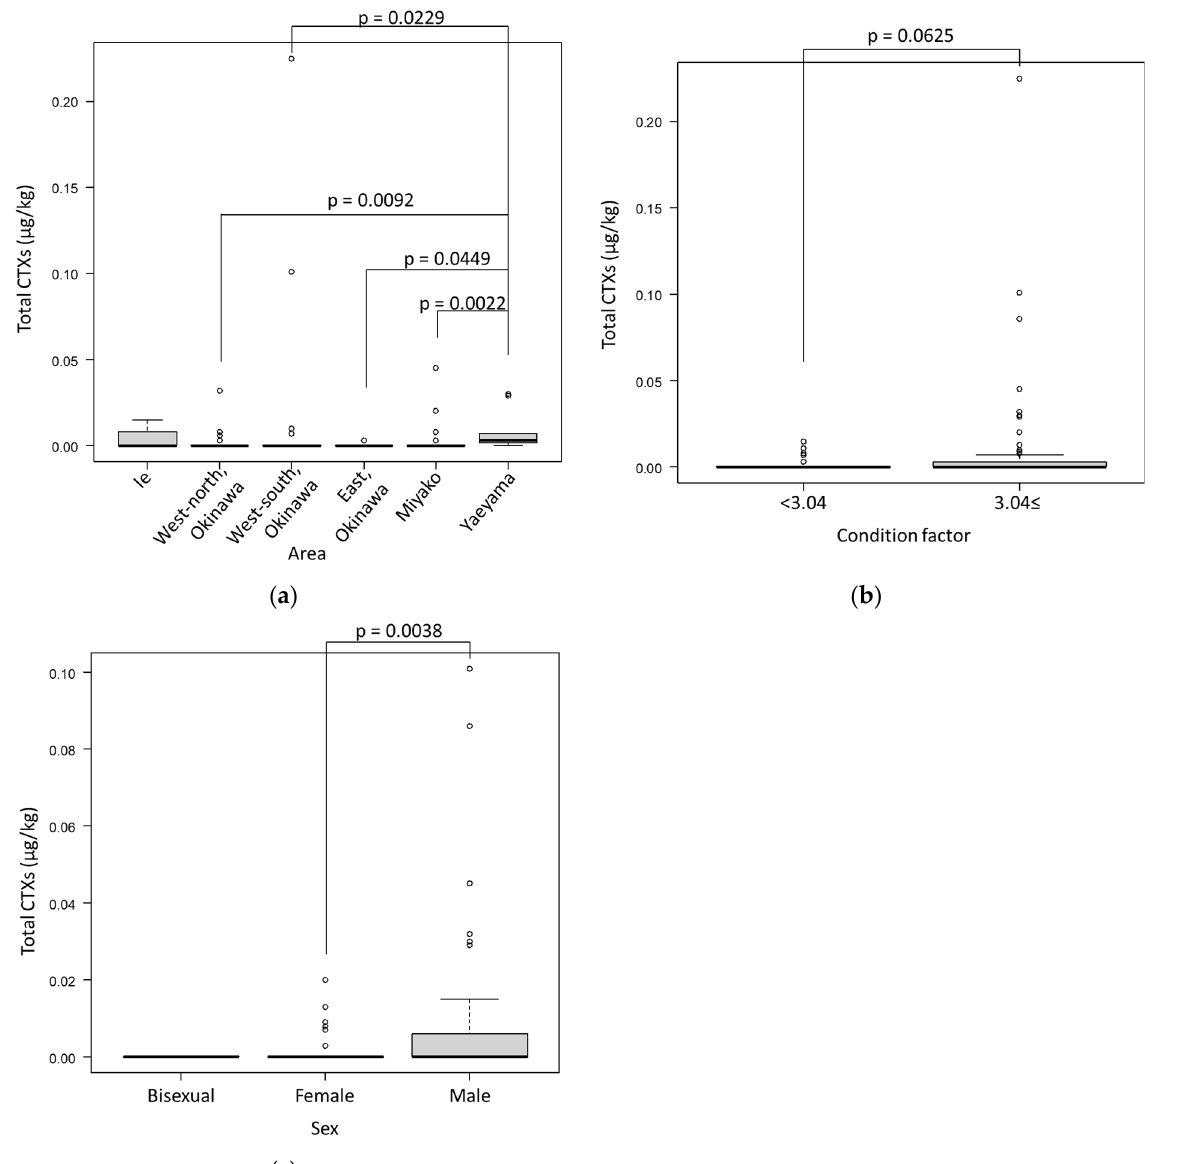
Figure 5. Distribution of total CTXS levels in the flesh of V. albimarginata captured from Okinawa, Japan, by ( a ) collected area, ( b ) condition factor (the median (3.04) was used as a criterion to divide the population into two groups), and ( c ) sex. The significances ( p < 0.05) were found and indicated with a p -value in ( a , c ). No significance was found, but the p -value was indicated in ( b ). The SL ranged from 13.0 to 33.7 cm (mean, 22.8 cm; median, 22.9 cm) and was positively correlated with the total CTX level (r = 0.488, p = 2.61 × 10 − 9 ; Figure 6a). The BW ranged from 61 to 1251 g (average, 398 g; median, 360 g) and was positively correlated with the total CTX level (r = 0.491, p = 2.01 × 10 − 9 ; Figure 6b). The CF ranged from 2.45 to 3.64 (mean, 3.03; median, 3.04) and showed no correlation with the total CTX contents (r = 0.13, p = 0.135; Figure 6c). When the median CF was used as a criterion to divide the population into thin (<3.04) and fat (3.04 ≤ ), there was no significant difference in the total CTX content between the two groups ( p = 0.0625). Still, the individuals with the highest total CTX levels were included in the fat group (Figure 5b). The 130 individuals whose ages could be estimated ranged from 1 to 15 years old (mean, 5.3 years; median, 5 years), and the age was positively correlated with total CTX levels (r = 0.403, p = 2.03 × 10 − 6 ; Figure 6d).